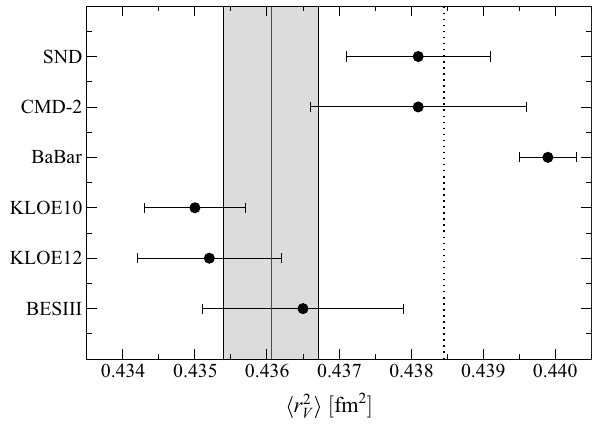
Fig. 6 Comparison of the values for the pion charge radius extracted from the analysis of the different vector form factor data sets. Only the results of our preferred Fit 2- ρ are shown. The red thick solid line denotes the average of the values, the gray band the corresponding uncertainty found omitting the contribution from BaBar. The average with the BaBar value included is shown as the perpendicular dotted line